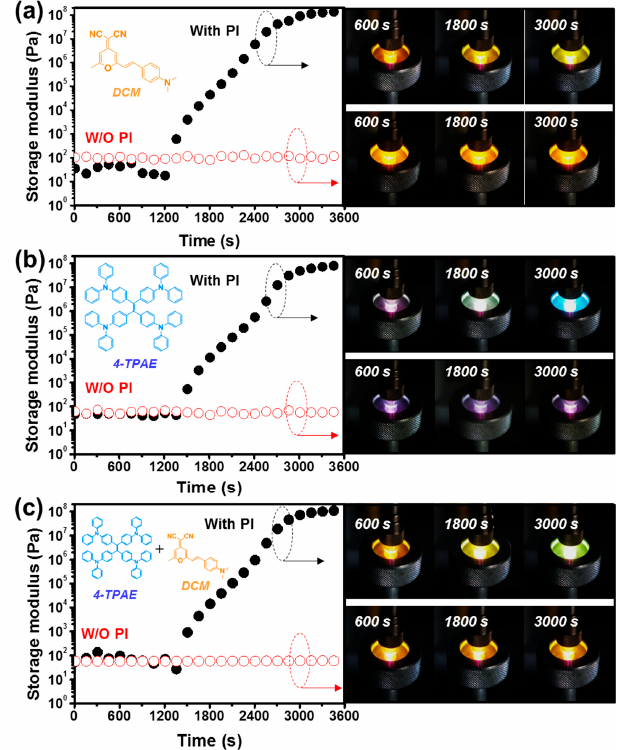
Figure 3. Photo-crosslinking of the healing agents was monitored using a rheology test at 1 Hz frequency under UV irradiation (black dots: healing agent with photo-initiator (PI); red dots: healing agent without photo-initiator). ( a ) DCM, ( b ) 4-TPAE, and ( c ) DCM/4-TPAE mixture in the healing agent.